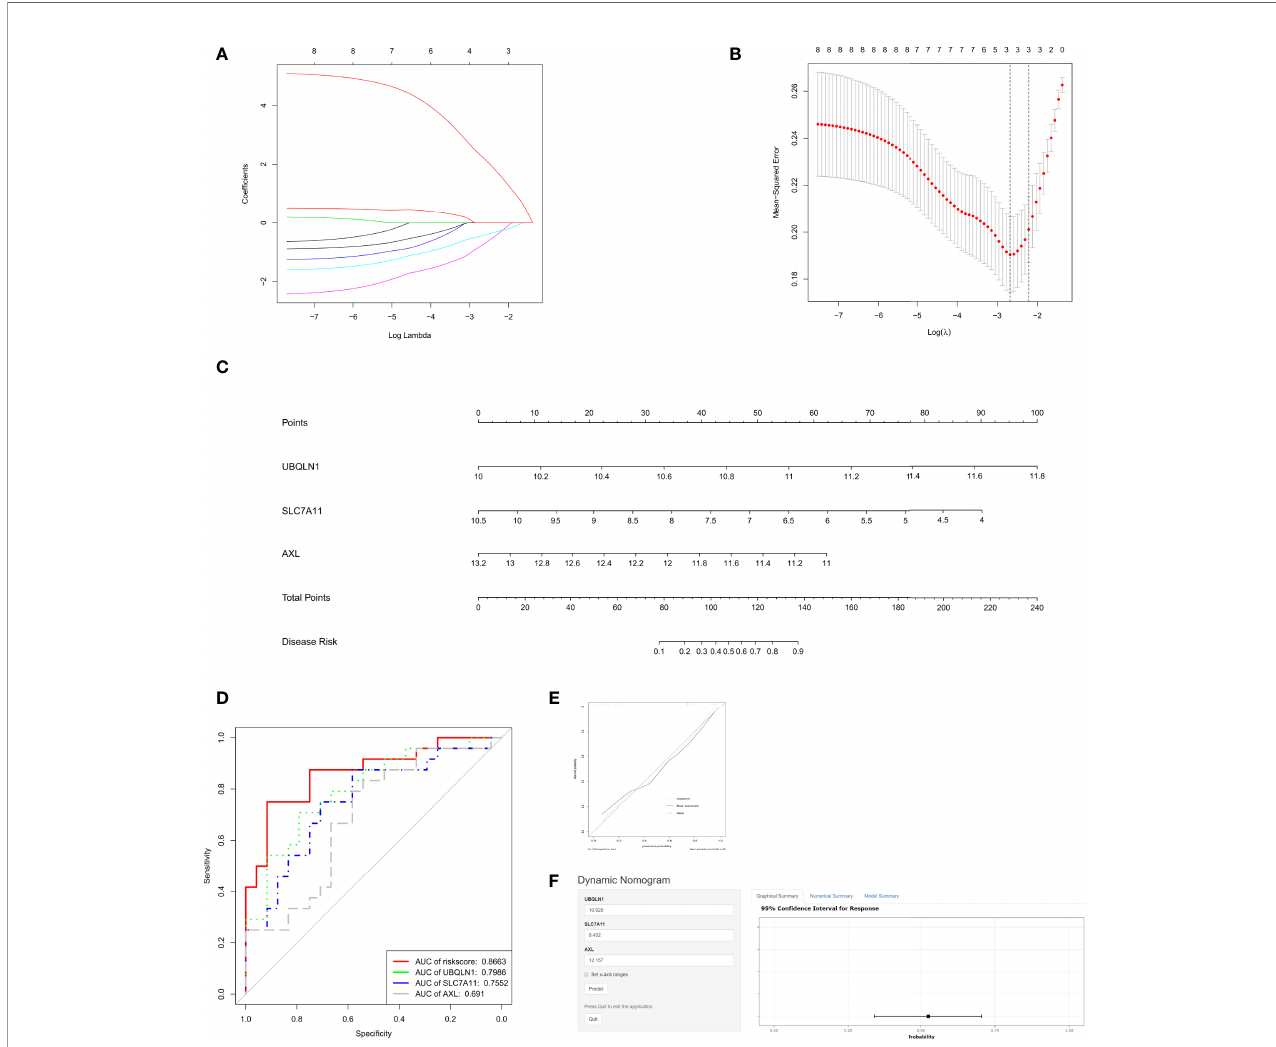
FIGURE 4 | Assessment of the recurrent implantation failure (RIF) predictive value of OSGs. (A) Log (Lambda) value of OSG. in least absolute shrinkage and selection operator (LASSO) model. (B) The most appropriate log (Lambda) value in the LASSO model. (C) Nomogram was developed by integrating the risk signature. (D) Receiver operating characteristic (ROC) curves for the RIF prediction according to the nomogram and each gene expression. (E) The calibration curve of the model. (F) The user-friendly free online calculator to facilitate the use of the nomogram.